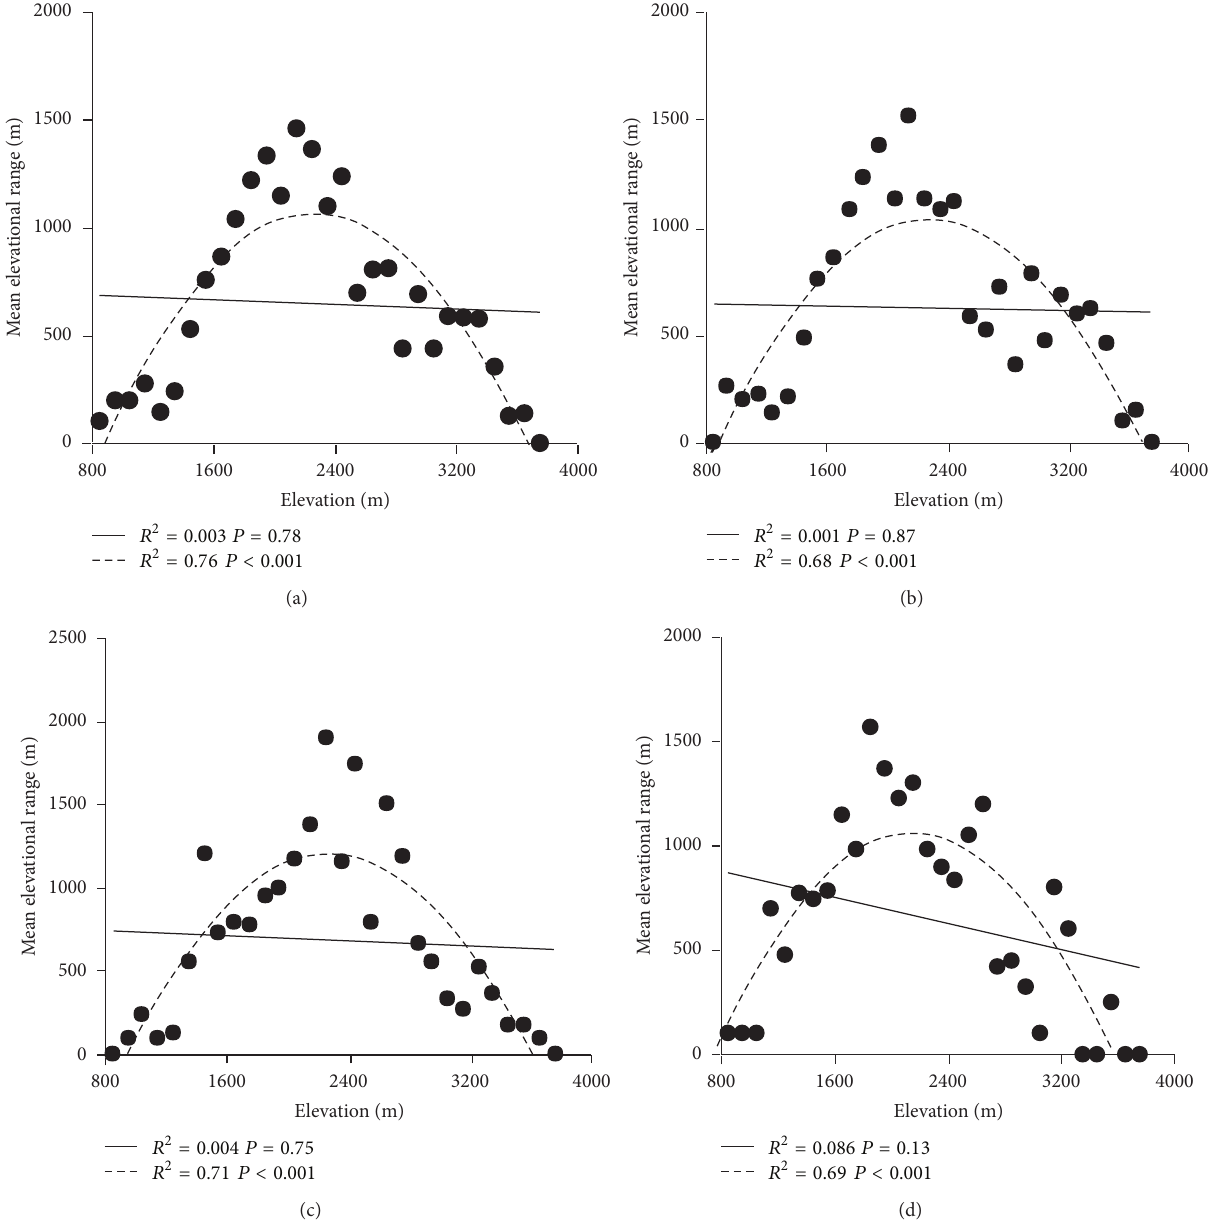
Figure 5: Midpoint method to test Rapoport’s elevational rule. The straight and the dotted curved lines show the simple linear and the second-order polynomial regression models, respectively. Overall plants (a), seed plants (b), bryophyte (c), and fern (d).